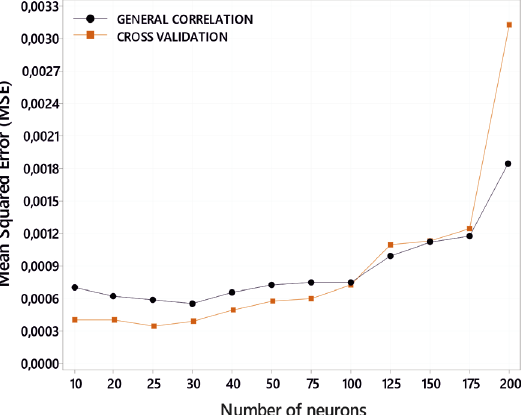
Figure 10. Mean squared error (MSE).